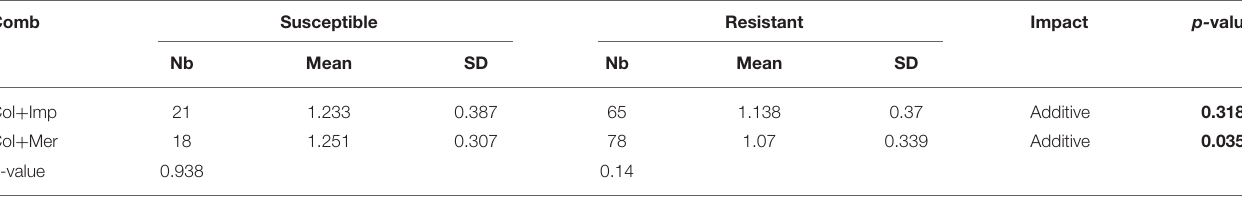
TABLE 3 | Combinations against carbapenem-resistant and susceptible Acinetobacter spp. Comb Susceptible Resistant